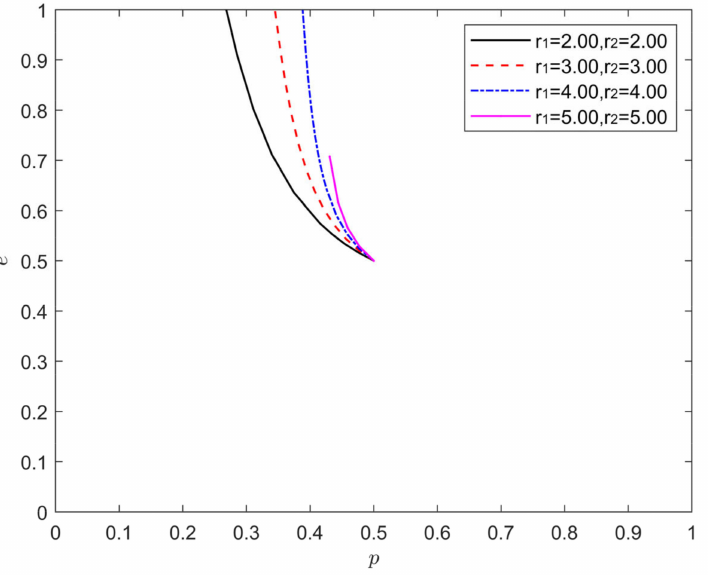
Figure 3. The development of the game’s strategy in a (pessimistic, pessimistic)